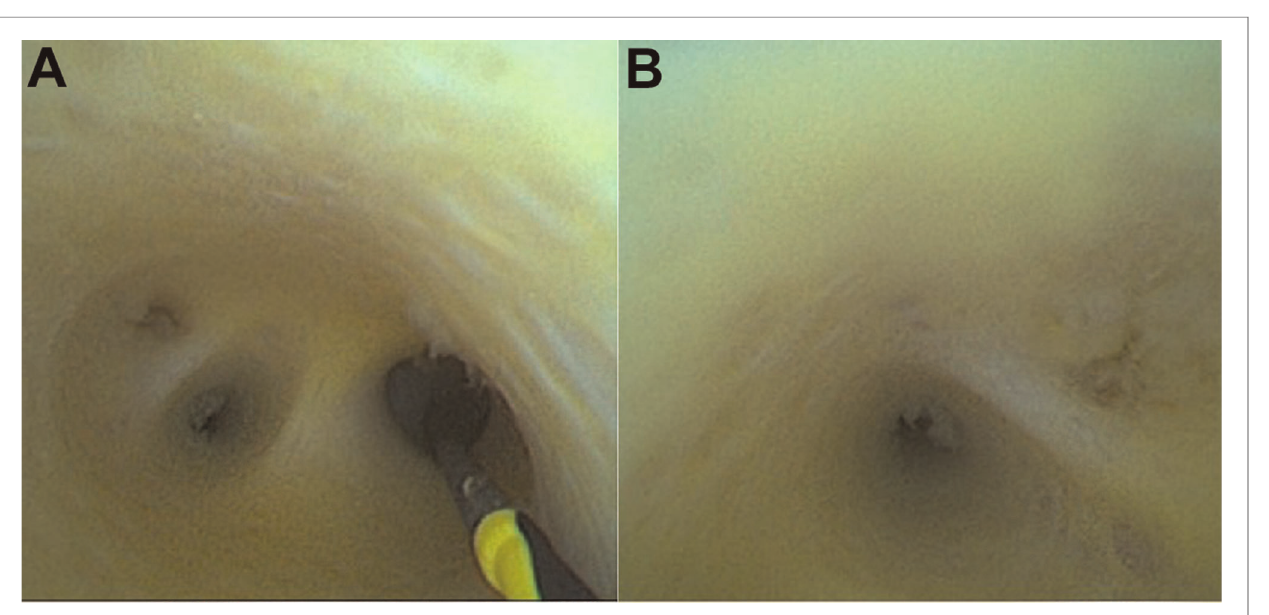
FIGURE 6 | Porta Hepatis Bile Duct ( A ) and Intrahepatic Fourth-Order Bile Duct ( B